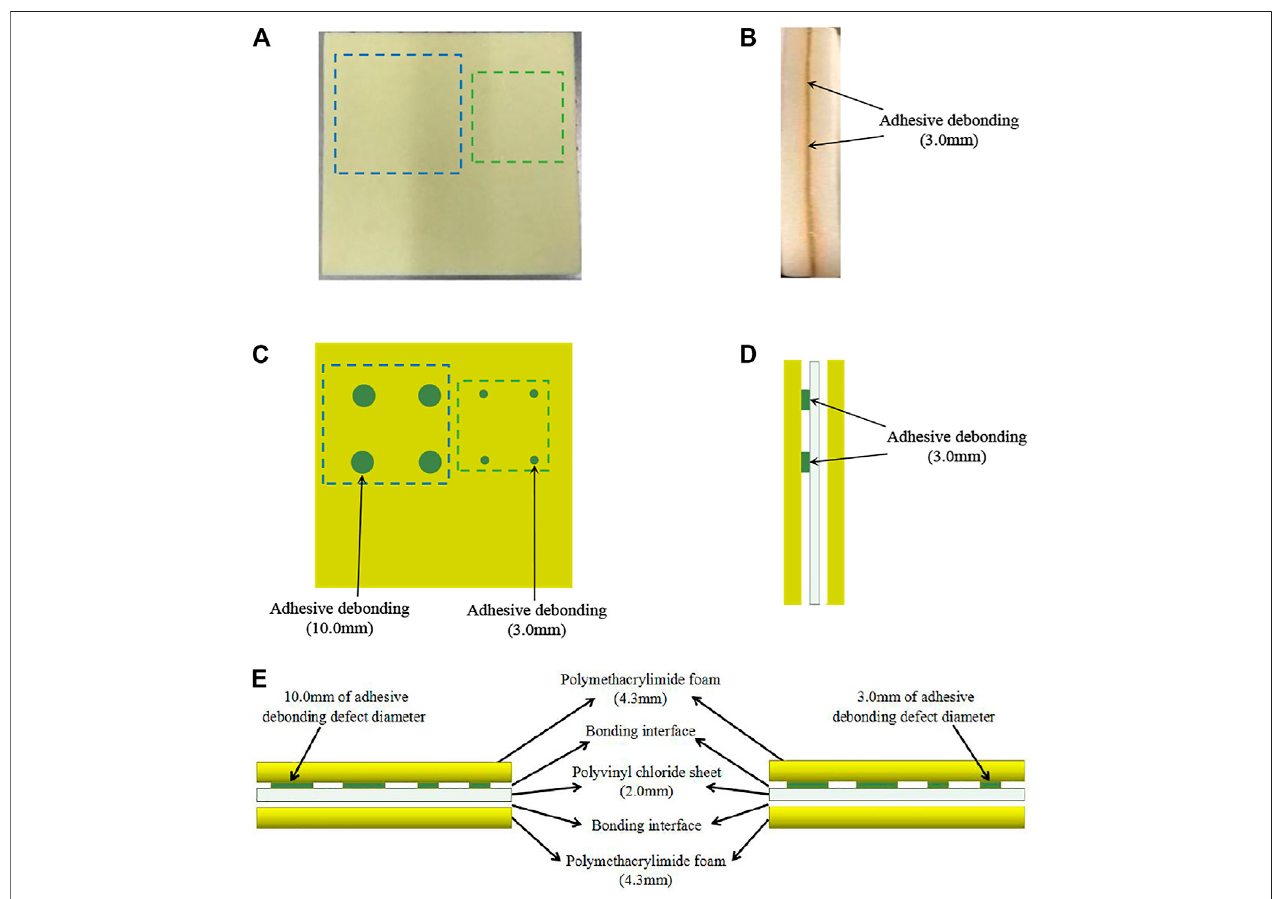
FIGURE 5 | The actual photos, defect location and size, structure diagram of polymethacrylimide foam and polyvinyl chloride sheet sandwich composite material. (A) the actual photo (top view) , (B) the actual photo (side view), (C) the diagram of defect location and size (top view) , (D) the diagram of defect location and size (side view), (E) the structure